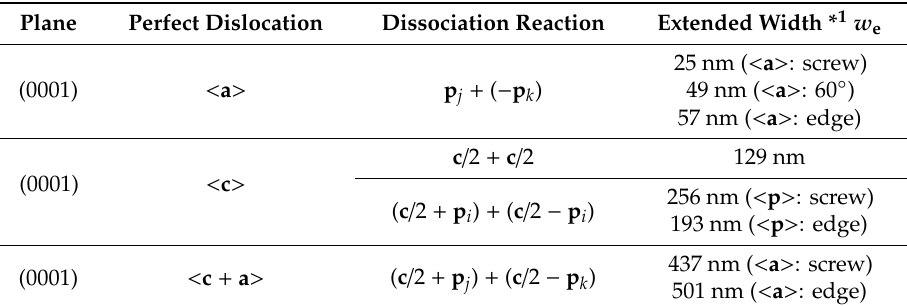
Table 1. Extended dislocations in